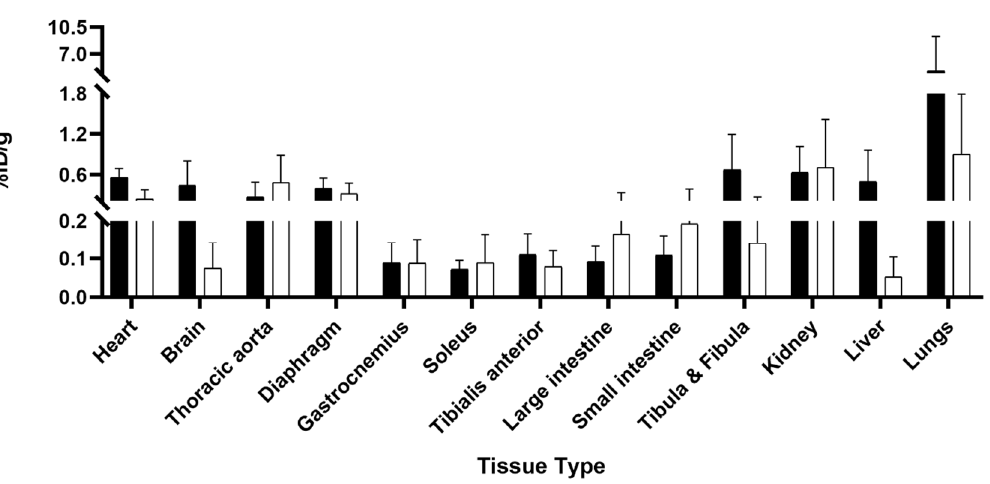
Figure A2. Multi-organ Biodistribution of [ 18 F]FEPPA within murine models. Data ( ± SE) shows the differences in radiotracer uptake as across multiple tissues as the percentage of the injected dose per gram of the tissue (%ID/g) of MDX ( mdx:utrn (+/−)) (black bars; n = 4 mice) and age-matched wild-type controls (white bars; n = 2 mice). No statistical analyses were conducted due to low sample sizes.